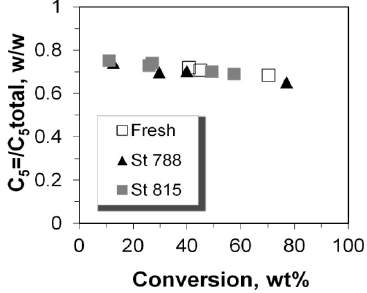
Figure 14. Olefinicity ratio for C 5 products.